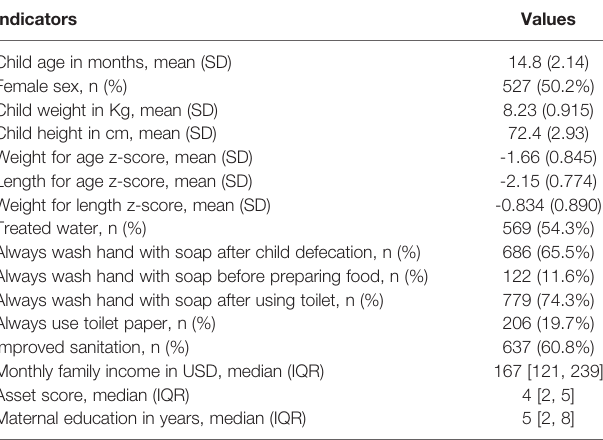
TABLE 1 | Baseline characteristics of children at enrollment (n = 1050). Indicators